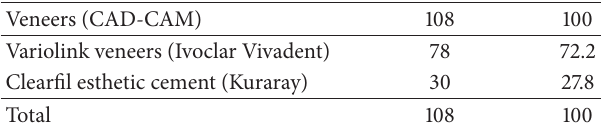
Figure 8: Adhesive cementation of the definitive veneers. Table 3: Distribution of PLVs according to bonding